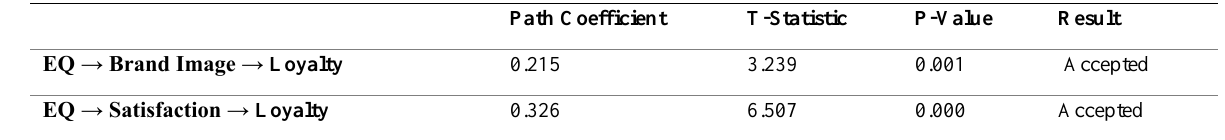
Table 7: Indirect Hypothesis